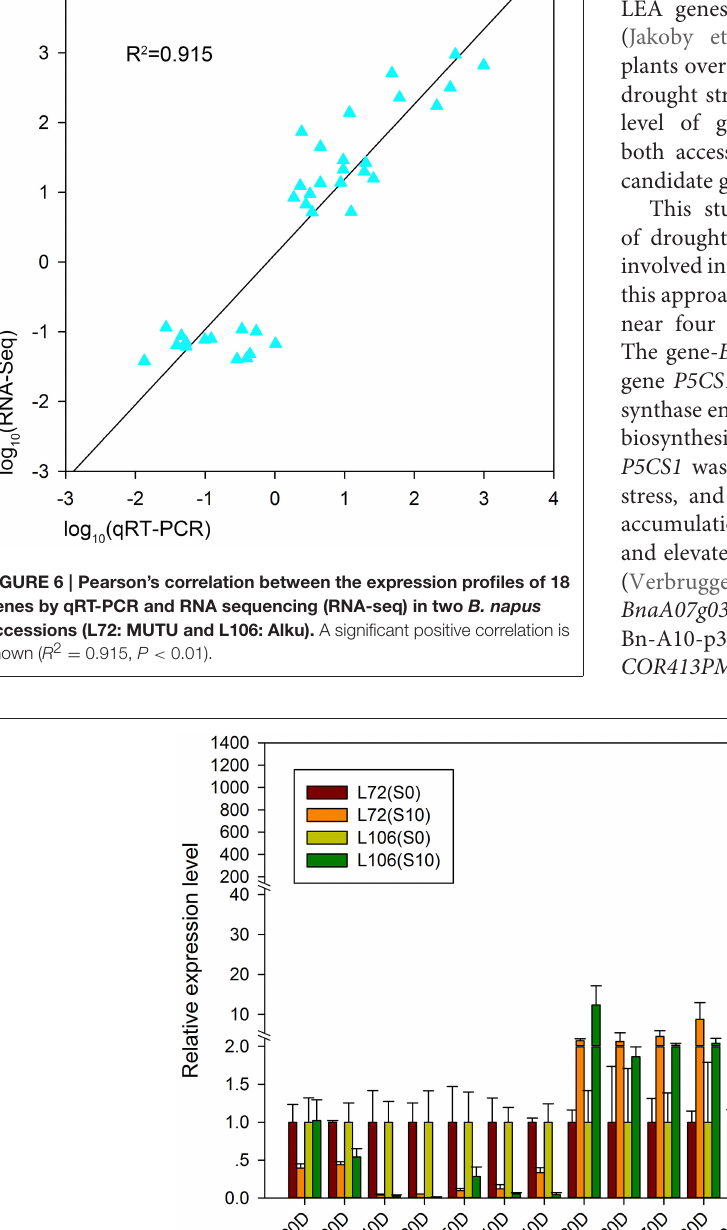
Frontiers in Plant Science |